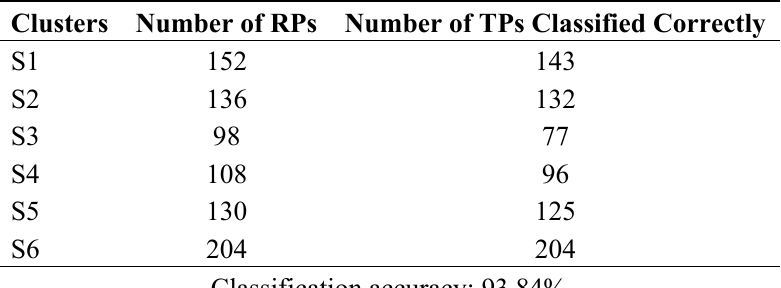
Table 3. Coarse Positioning performance of SDC